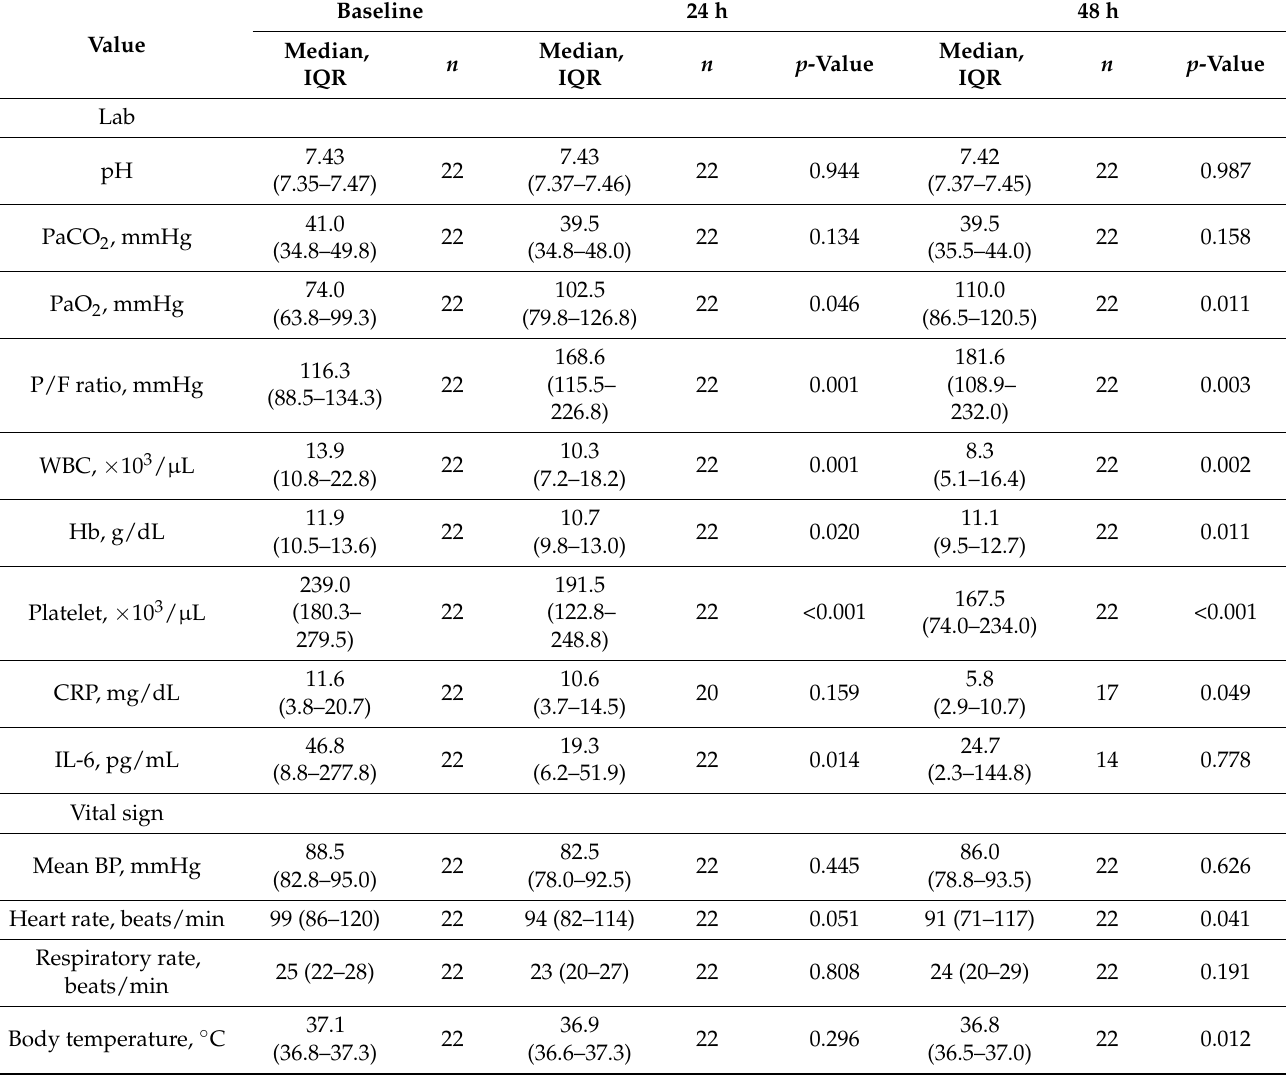
Table 3. Clinical course of laboratory data before and after PMX-DHP treatment based on the Wilcoxon